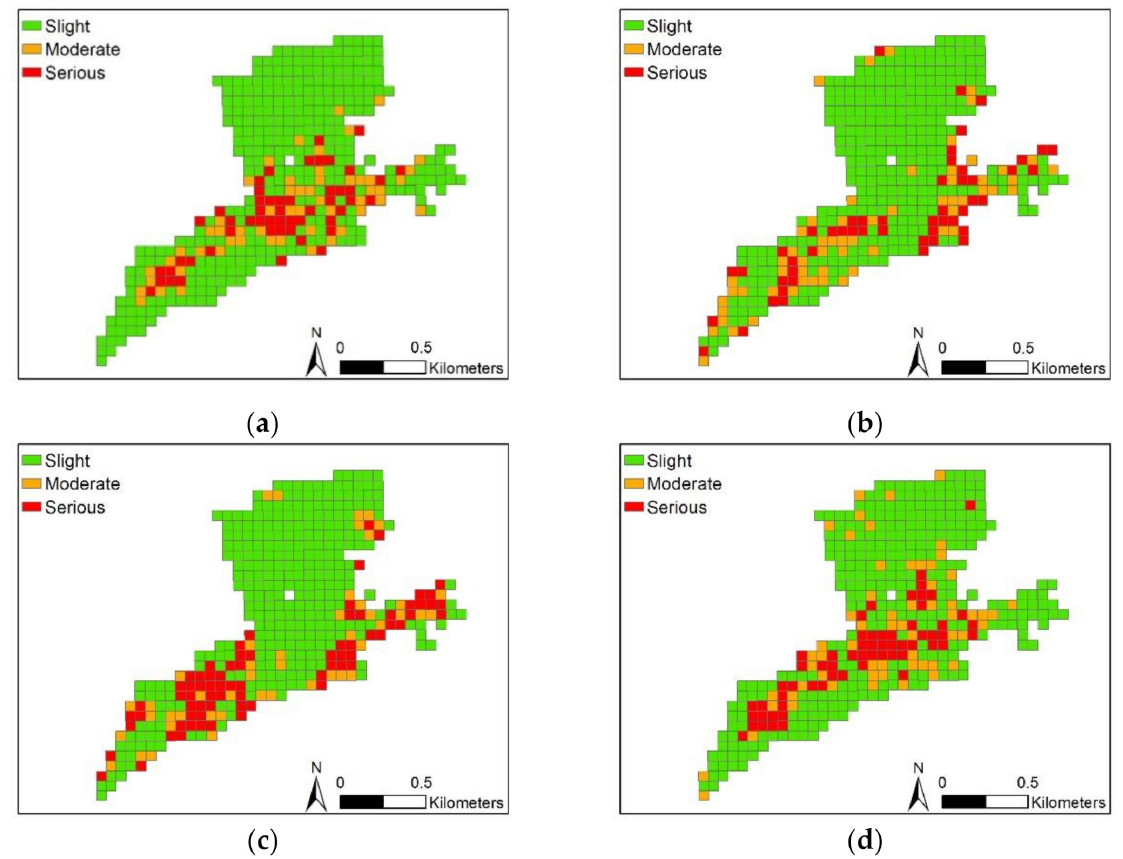
Figure 31. Grid-level reference map and damage maps in Mashiki town. ( a ) Reference map; ( b ) damage map from the H − α − ρ method; ( c ) damage map from the PWMF method; ( d ) damage map from the proposed